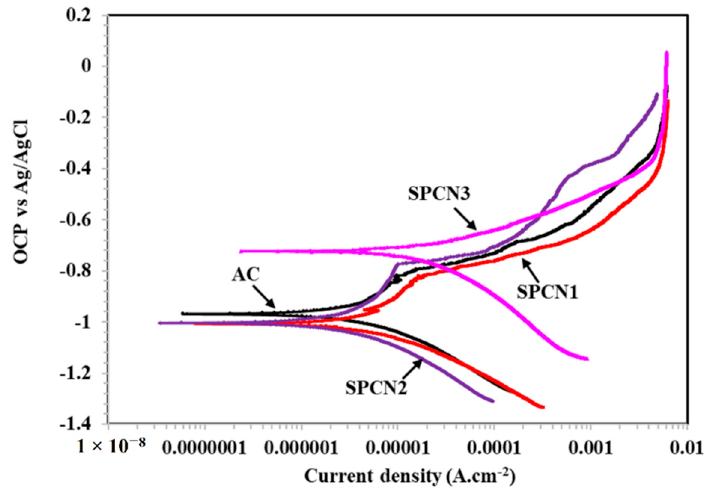
Figure 9. Potentiodynamic plot of coatings after 89 days of exposure in 3.5 wt.% NaCl solution.